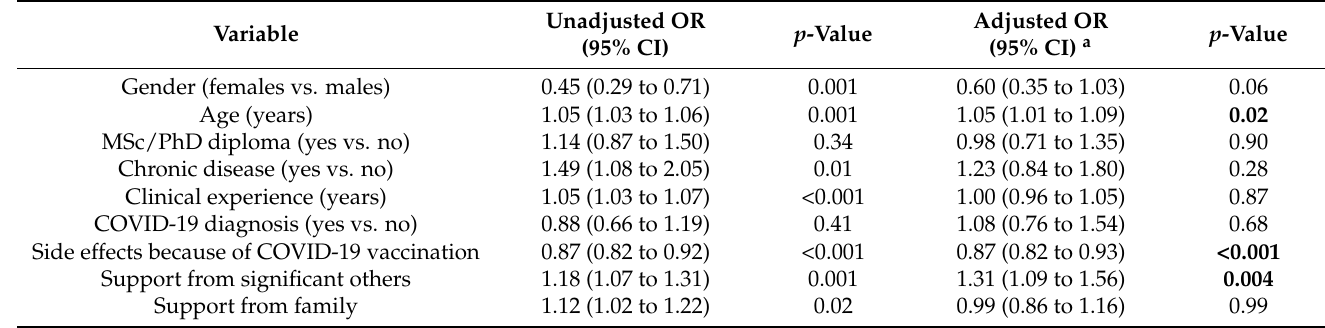
Table 4. Univariate and multivariable logistic regression analysis with influenza vaccination willing- ness as the dependent variable (reference category: hesitant/unwilling